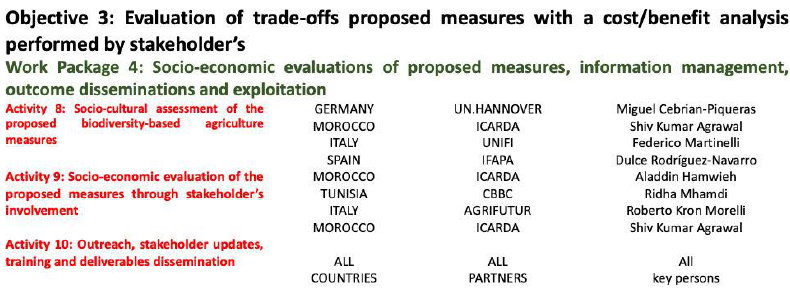
Figure 4. Objectives, activities, countries, and institutions of Legu-med proposal.